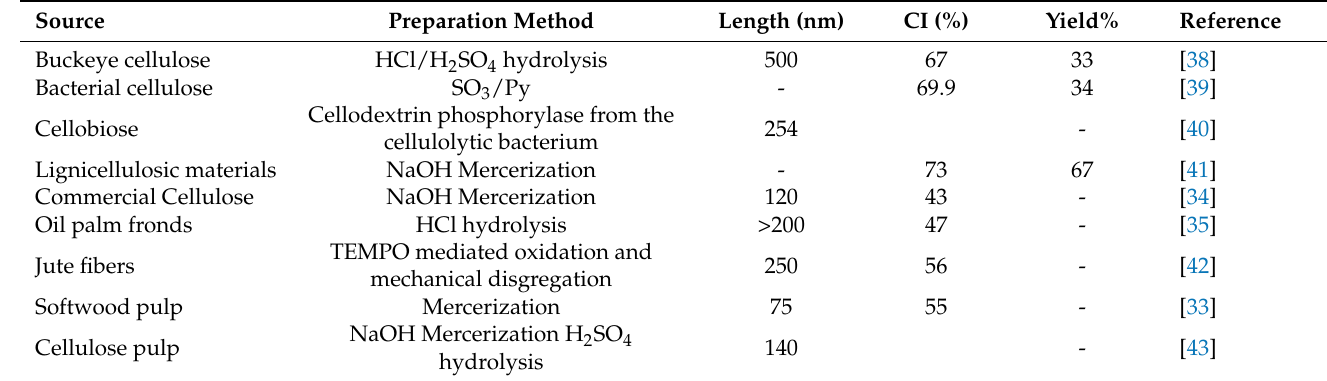
Table 1. Synthesis methodologies and characteristics of CNC polymorph